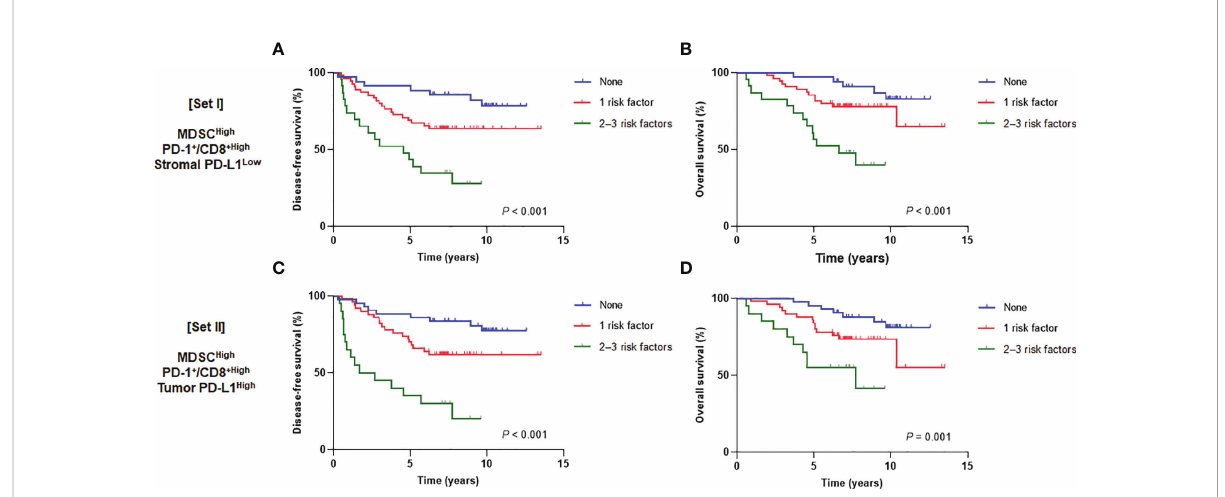
FIGURE 5 Disease-free survival ( left ) and overall survival ( right ) curves according to the number of risk factors from (A, B) set I (MDSCs, PD-1 + /CD8 + TIL ratio, and stromal PD-L1) and (C, D) set II (MDSCs, PD-1 + /CD8 + TIL ratio, and tumor PD-L1). MDSC, myeloid-derived suppressor cell; PD-1, programmed cell death-1; TIL, tumor-in fi ltrating lymphocyte; PD-L1, programmed death-ligand